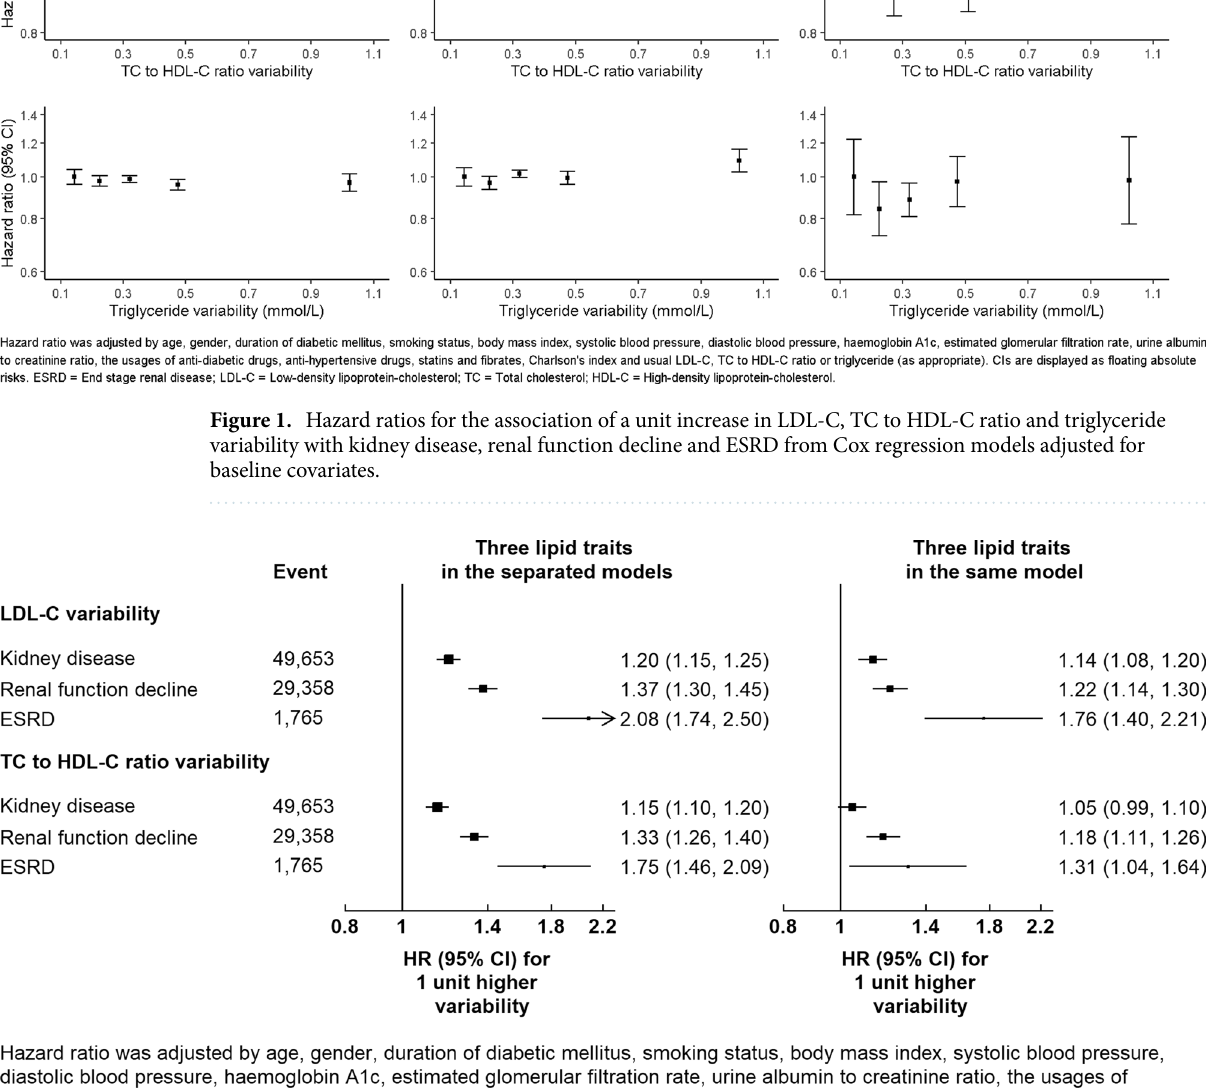
Figure 2. Hazard ratios for the risk of kidney disease, renal function decline and ESRD with each 1 unit increasing LDL-C or TC to HDL-C ratio variability using Cox regressions adjusted for baseline